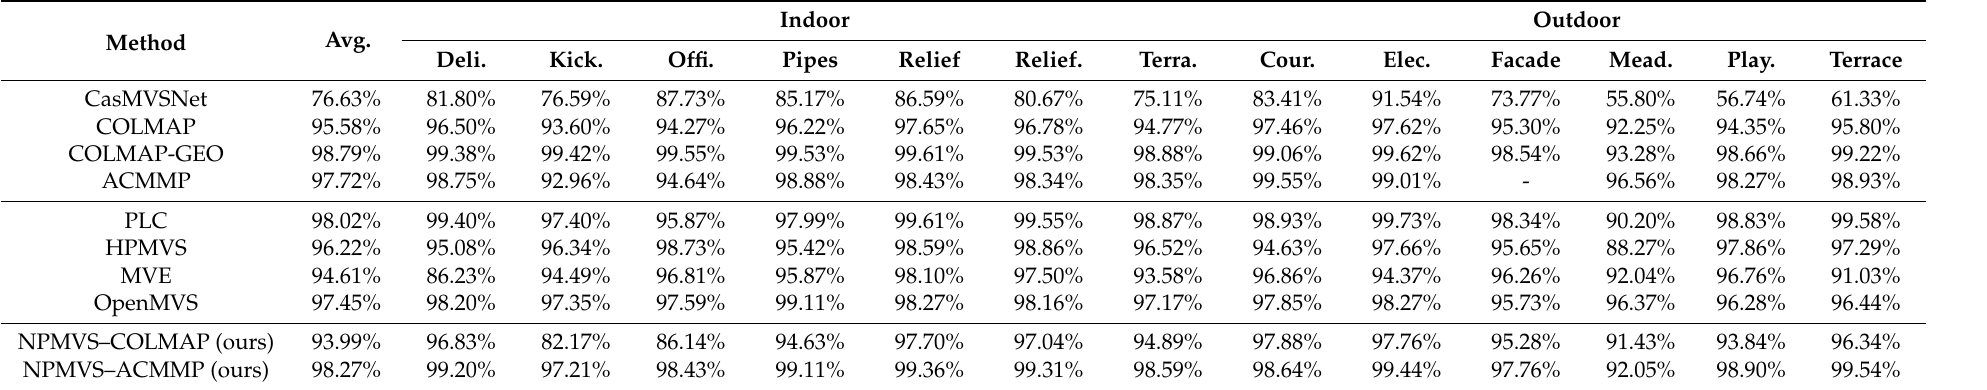
Table 2. Comparison of accuracy (higher is